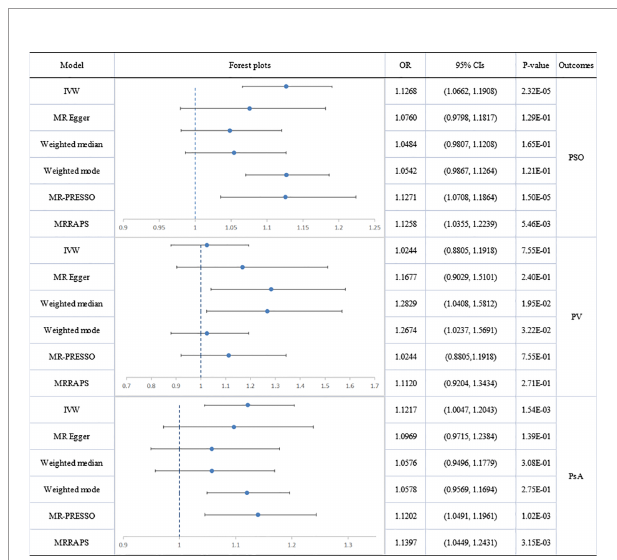
FIGURE 3 | Causal estimates given as odds ratios (ORs) and 95% con fi dence intervals for the effect of in fl ammatory bowel disease on psoriasis